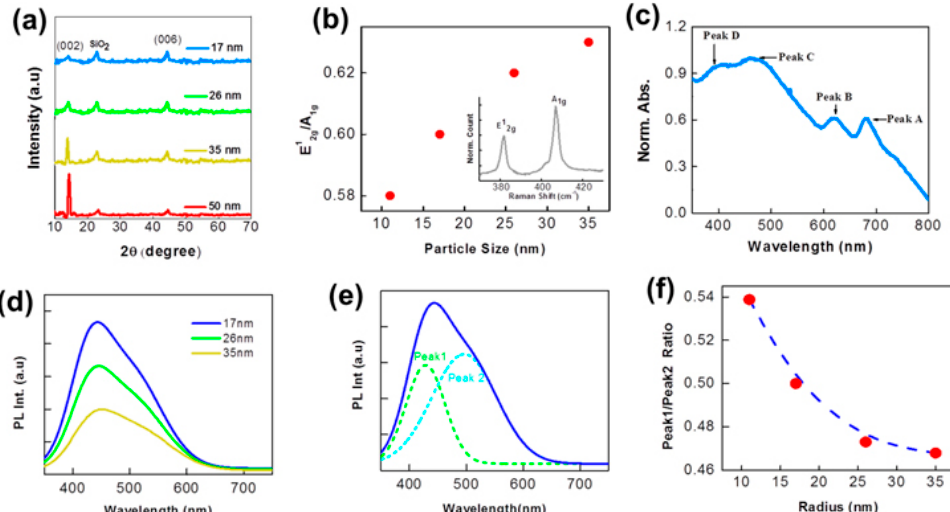
Figure 6. ( a ) XRD diffraction pattern of MoS 2 nanoparticles of different sizes. ( b ) Variation of the ratio of characteristic Raman peak intensity with particle size. The inset shows a typical Raman spectrum of MoS 2 nanoparticles with an average size of ~17 nm. ( c ) Typical absorption spectrum of MoS 2 nanoparticles exhibiting different peaks. ( d ) PL spectrum of different sized nanoparticles (excitation = 325 nm). ( e ) Deconvolution of the PL spectrum of ~17 nm nanoparticles in two Gaussian curves. ( f ) Variation of the intensity ratio of the two PL peaks with particle size. Reproduced with permission from [42]. IOP Publishing Ltd, 2020.